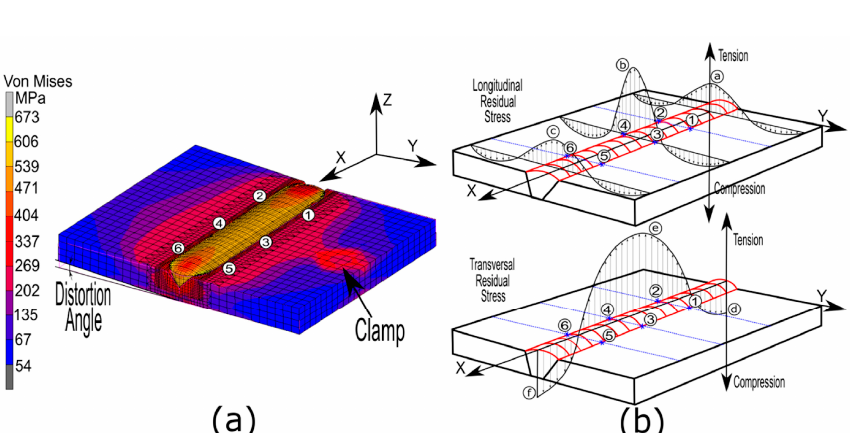
Figure 8. ( a ) Von Mises stresses obtained from the FE model of a butt joint with a single V ‐ groove for the first specimen studied; ( b ) theoretical distribution of longitudinal and transverse stresses for welding any butt welded joint with single V ‐ groove (Reprint from [90]).